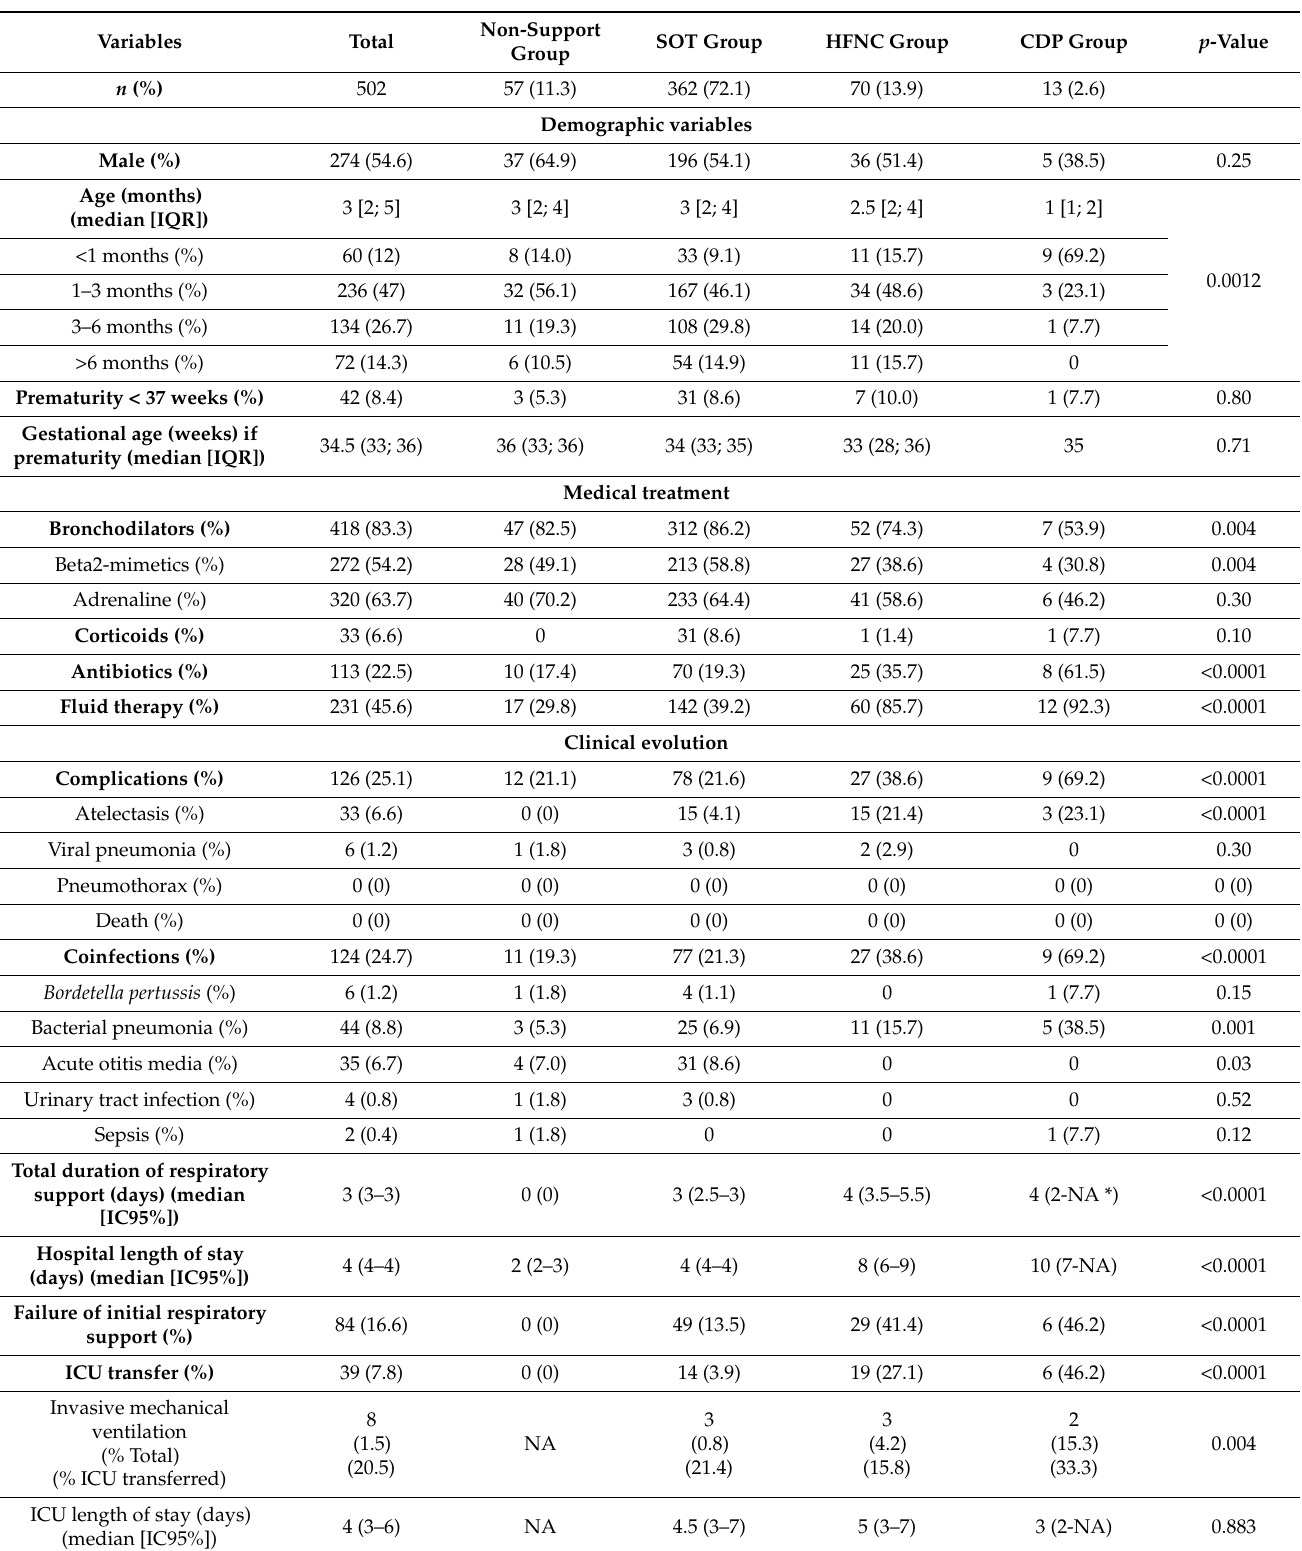
Table 1. Description of the sample: global and by initial respiratory support